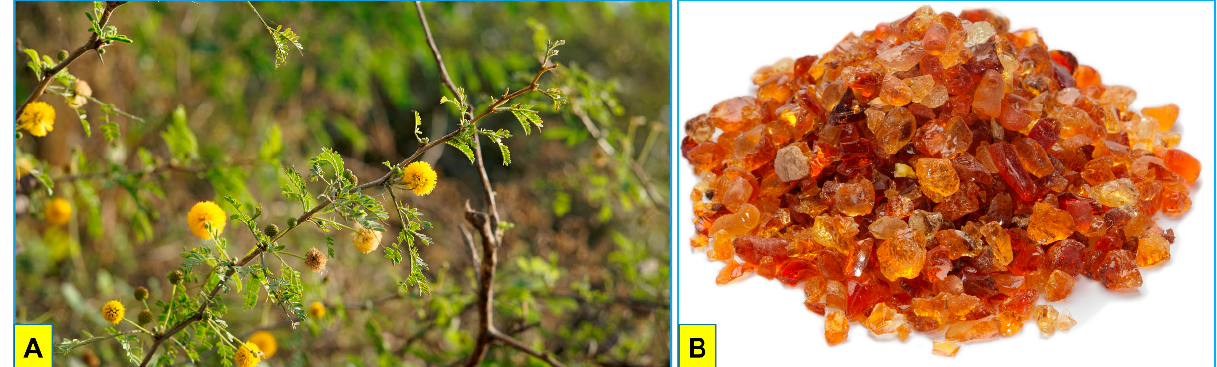
Figure 1. Photographs showing ( A ) Acacia seyal and ( B ) Gum Arabic.